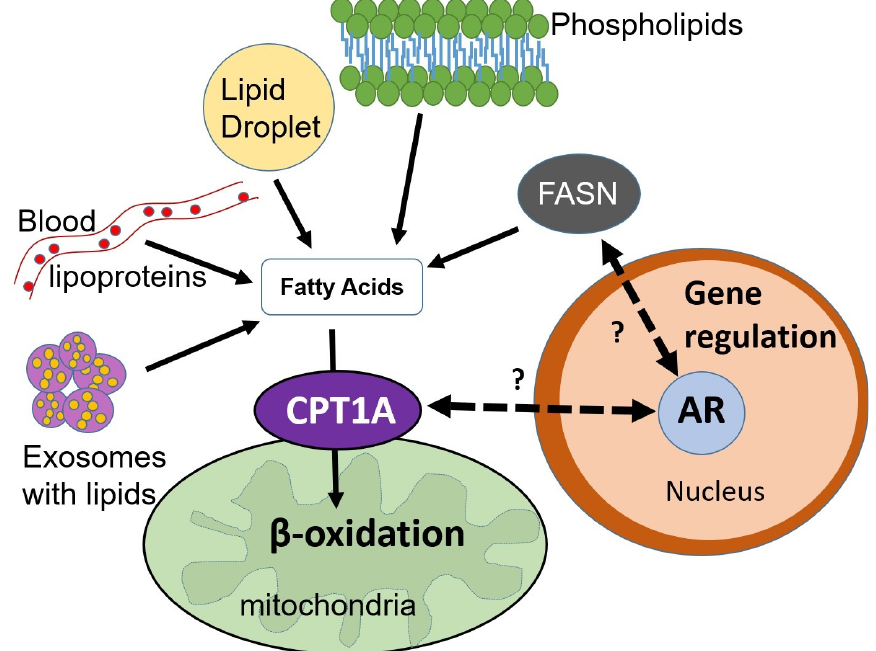
Figure 3. Androgen control of lipid metabolism by Stoykova and Schlaepfer via Creative Commons CC BY 4.0 [37].